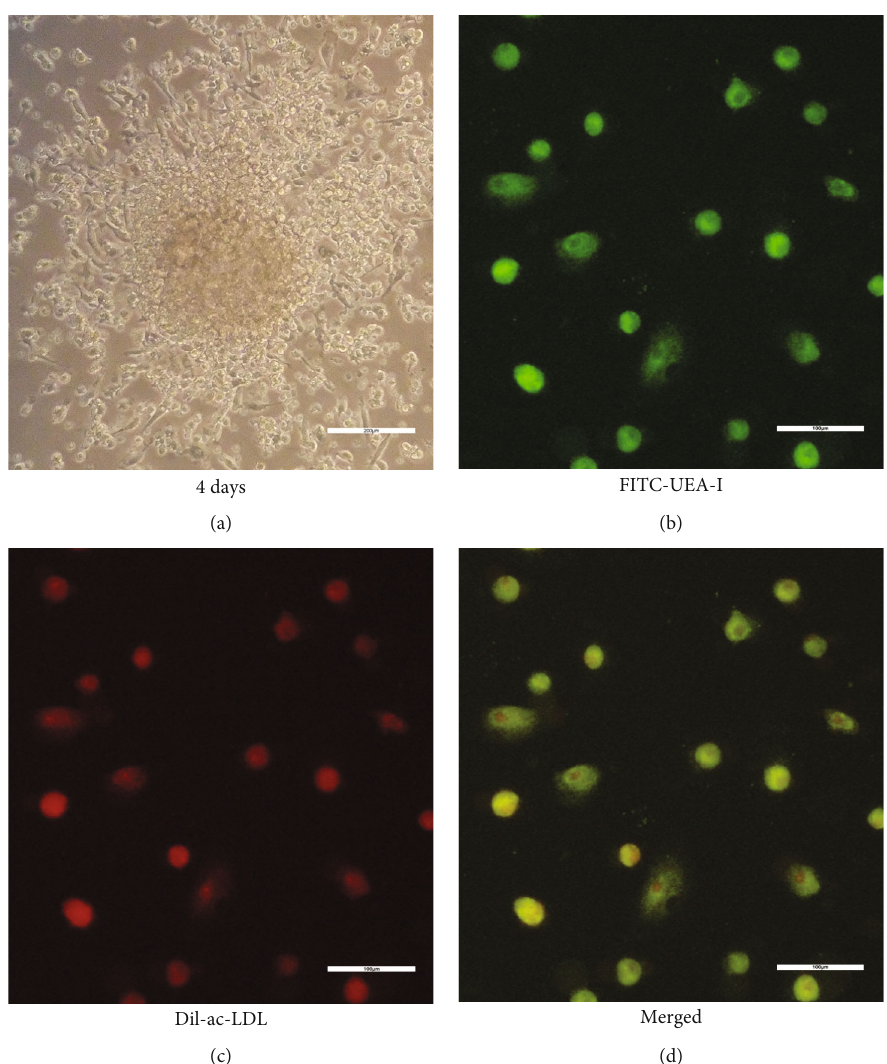
Figure 1: Characterization of endothelial progenitor cells (EPCs) from human peripheral blood. (a) The formation of EPC colonies. Cord- like structures formed by adherent cells. Spindle-shaped cells sprouted from the edges of cell clusters. Scale: 200 μ m. (b – d) The fl uorescent image showed Dil-acetylated low-density lipoprotein (Dil-acLDL) incorporation (red) and FITC lectin (FITC-UEA-1) binding (green) by EPCs. Scale: 100 μ